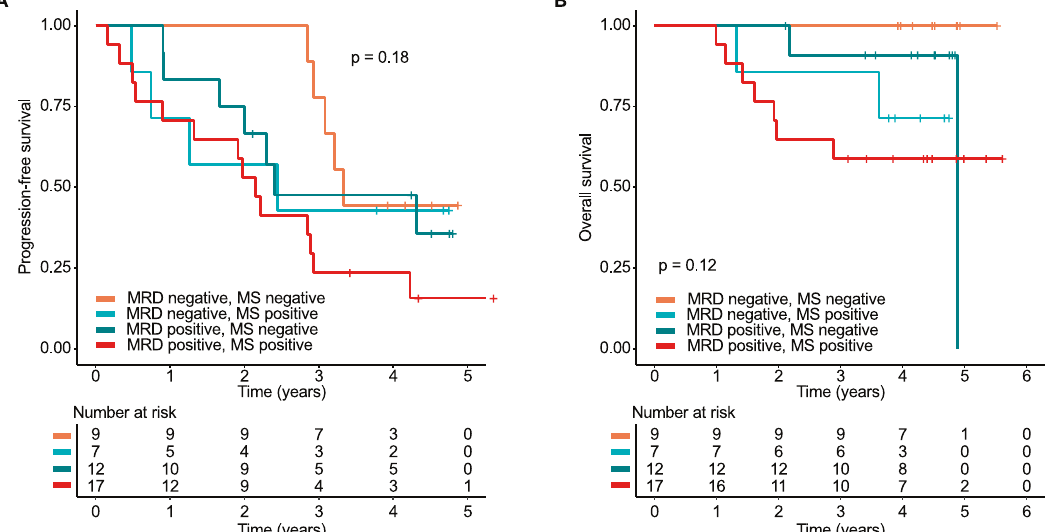
Fig. 6 Prognostic impact of the combination of minimal residual disease and mass spectrometry. A PFS and ( B ) OS landmark analysis from assessment of minimal residual disease (MRD) in the bone marrow (sensitivity 10 − 6 ). Patients were grouped according to MRD and mass spectrometry (MS) status at this time point. Four groups were de fi ned: MRD positive/MS positive, MRD negative/MS positive, MRD positive/MS negative, MRD negative/MS